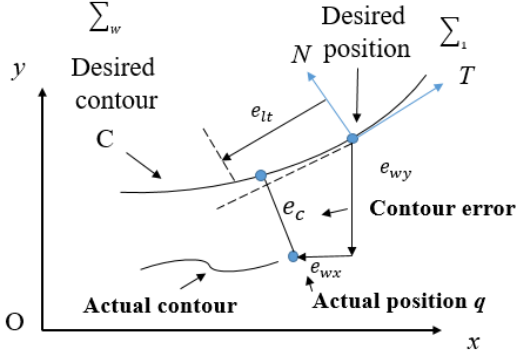
Figure 1. Calculation diagram of Contour error [1–3].